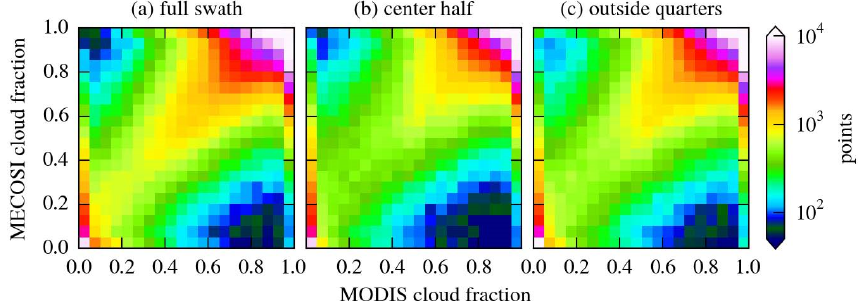
Figure 8. Comparison of daily gridded MECOSI and MODIS cloud fraction using the full MERIS swath (a) , the center half (b) or the outside quarters (c) for the gridded MECOSI fraction. Period is May to September